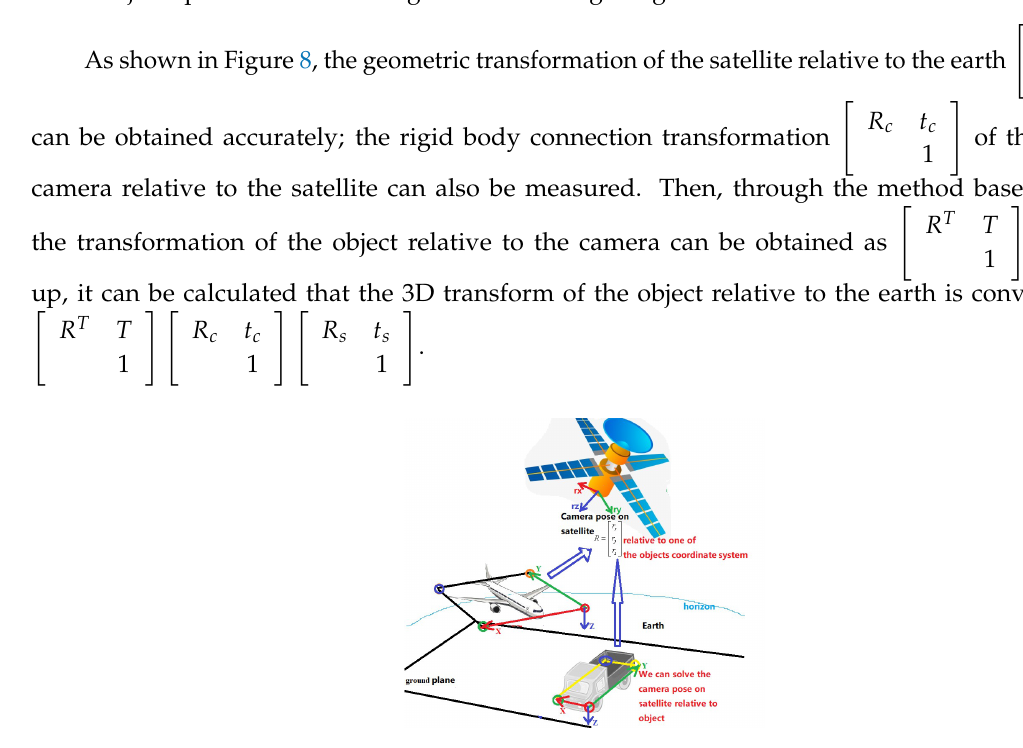
Figure 8. Application of remote sensing image for object spatial location.